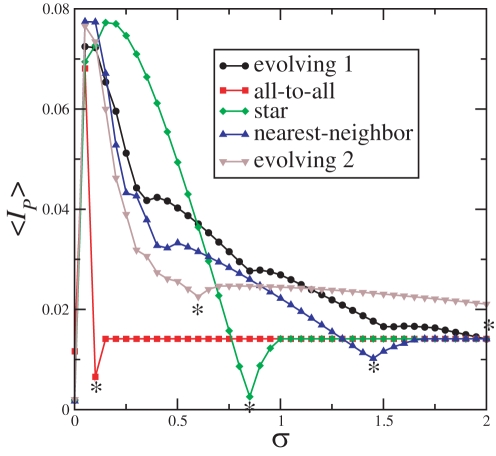
The average value of the upper bound MIR, 〈IP〉 [as defined in Eq. (10)] for active networks composed of 8 elements using one of the many topologies obtained by evolving the network maximizing B1 (circles), all-to-all topology (squares), star topology (diamonds), nearest-neighbor (upper triangle), and maximizing B2 (down triangle).The values of  indicated by the starts are  (evolving 1),  (all-to-all),  (star),  (nearest-neighbor), and  (evolving 2). The evolving 1 network has a Laplacian with relevant eigenvalues γ7 = 3.0000, γ8 = 6.1004, which produces a cost function equal to B1 = 1.033. The evolving 2 network has a Laplacian with relevant eigenvalues γ2 = 0.2243 and γ3 = 1.4107, which produces a cost function equal to B2 = 5.2893.